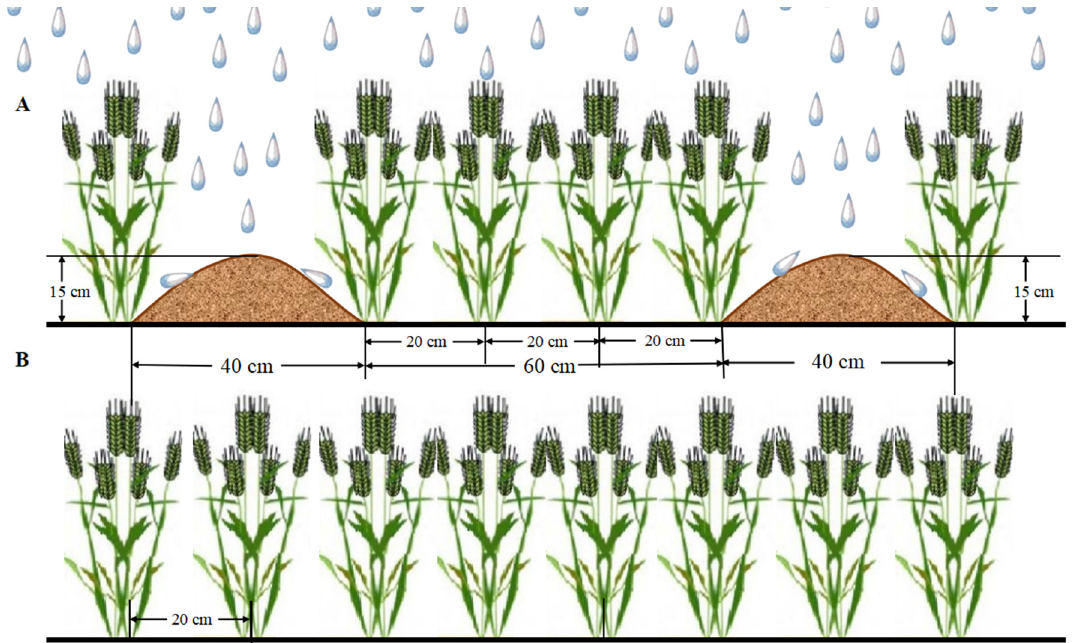
Figure 1. Schematic diagram of the field layout. ( A ) Ridge covered with plastic film mulch. ( B ) Traditional flat planting.